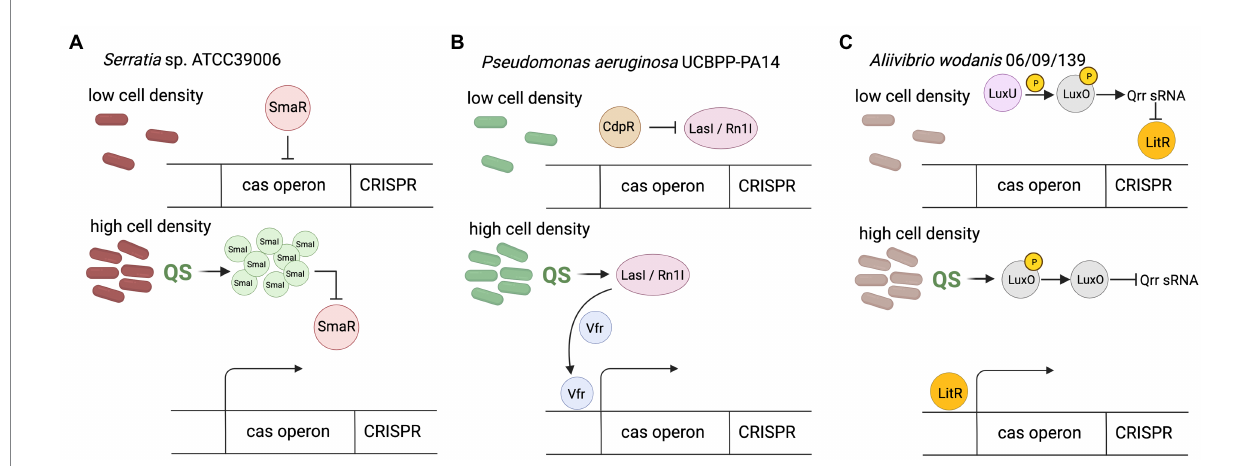
FIGURE 1 CRISPR-Cas regulation by quorum sensing. (A) In Serratia sp. at low cell density in the absence of SmaI autoinducer SmaR acts as the repressor of the expression of cas genes and CRISPR array. The increase of cell density lead to SmaI accumulation, which bind to SmaR, thereby inhibiting its DNA binding activity and resulting in derepression of expression of CRISPR-Cas system. (B) In Pseudomonas aeruginosa at low cell density CdpR indirectly inhibits binding of virulence factor regulator (Vfr) to the cas promoter by repressing QS regulators (LasI/RhlI). Increase of cell density causes that LasI/ RhlI activate expression of the cas operon by stimulating Vfr binding. Vfr is required for the CdpR-mediated regulation of CRISPR-Cas function. The function of Vfr is activated by QS autoinducers and repressed by QS inhibitors, so depends on cell density (CdpR represses QS regulators to inhibit CRISPR-Cas immunity through the Vfr signaling. However, the detailed mechanism remains to be defined). (C) In Aliivibrio wodanis at low cell density, when the AIs concentration is low, the receptors LuxU relays phosphate to LuxO, which activates the expression of Qrr sRNA. The Qrr sRNA inhibits the expression of LitR. At high cell density dephosphorylate LuxO occurs and inactivation of Qrr sRNA. Inactivation of Qrr sRNA activates LitR, positively regulates expression of the the cas operon. Created with